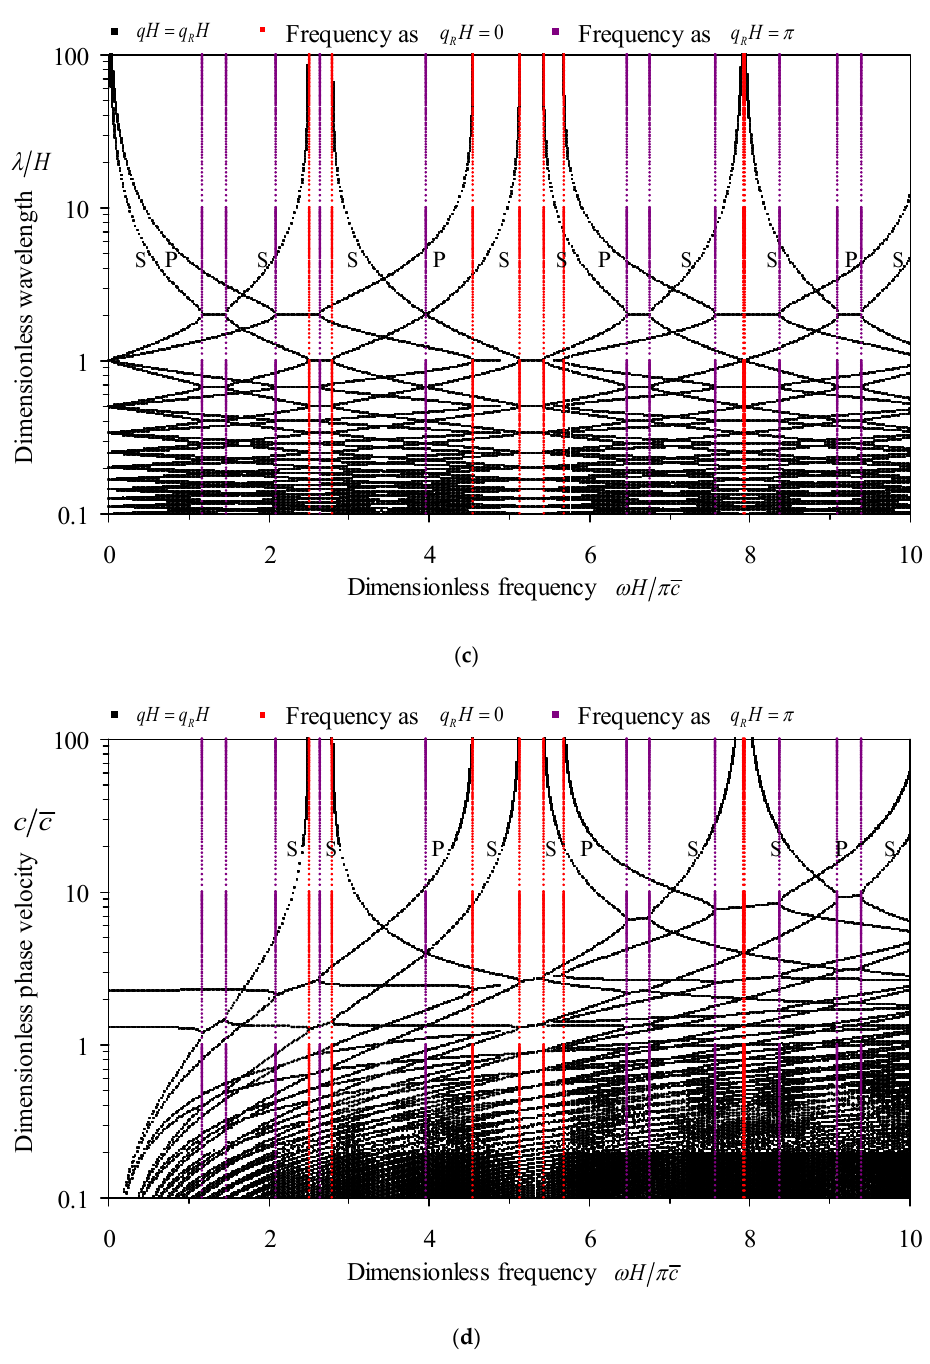
Figure 6. The comprehensive frequency-related dispersion curves of elastic waves in periodic Glass-Brass-(PZT-5H 1 )-Brass multilayers: ( a ) The eigenvalue amplitude | µ | spectra; ( b ) The wavenumber spectra; ( c ) The wavelength spectra; ( d ) The phase velocity spectra.